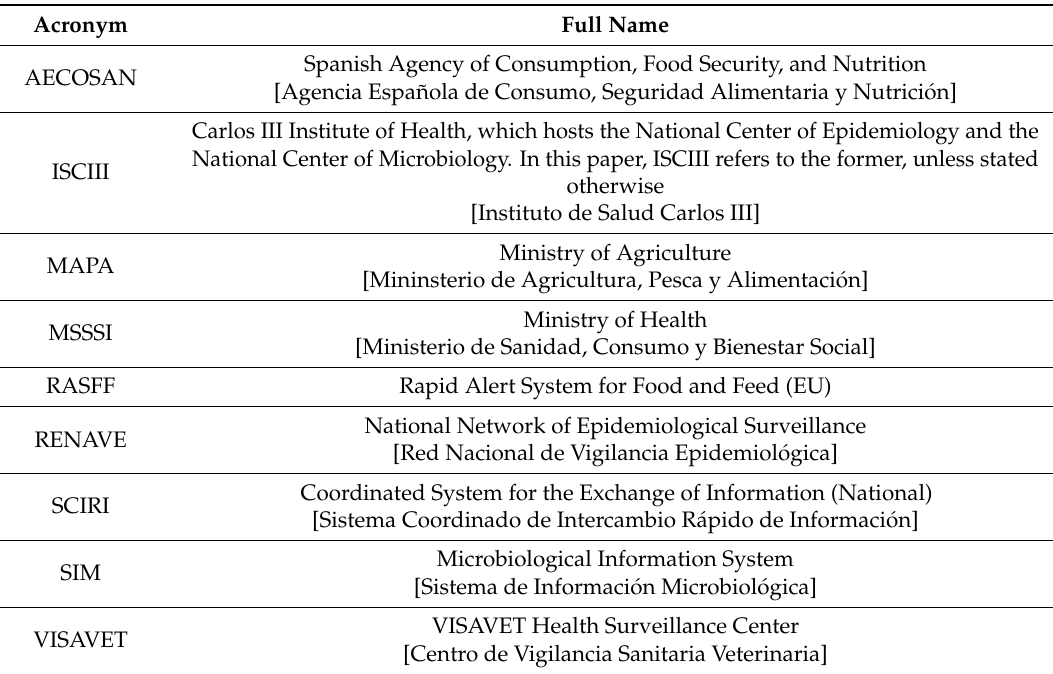
Table 1. List of acronyms of institutions and systems used in this